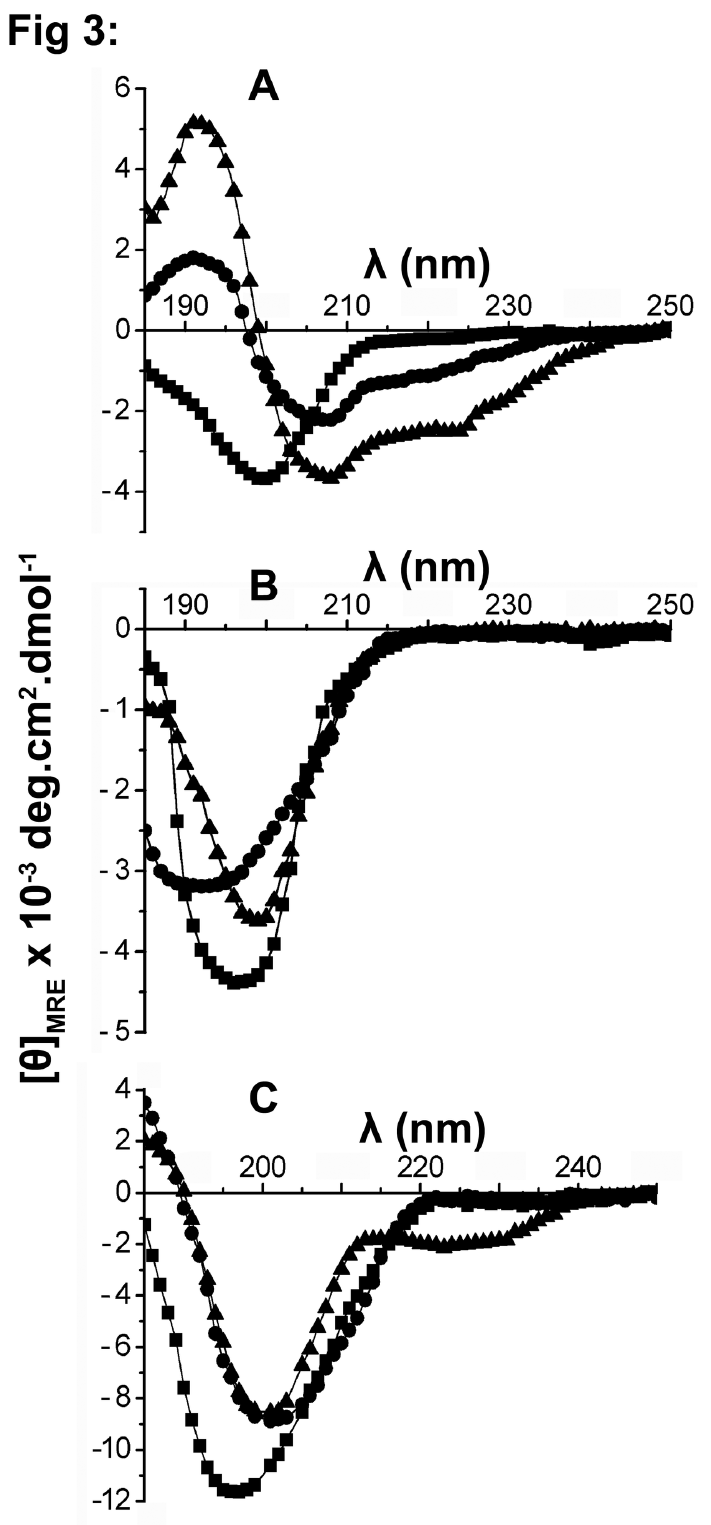
Figure 3. Circular dichroism spectra of peptides. (A) HC-1(R), (B) [D]HC-1(R) , (C) [D]HC-3(R). CD spectra were recorded in 10 mM phosphate buffer (■), 10 mM SDS (●) and TFE (▲). doi: 10.1371/journal.pone.0077031.g003 PLOS ONE |